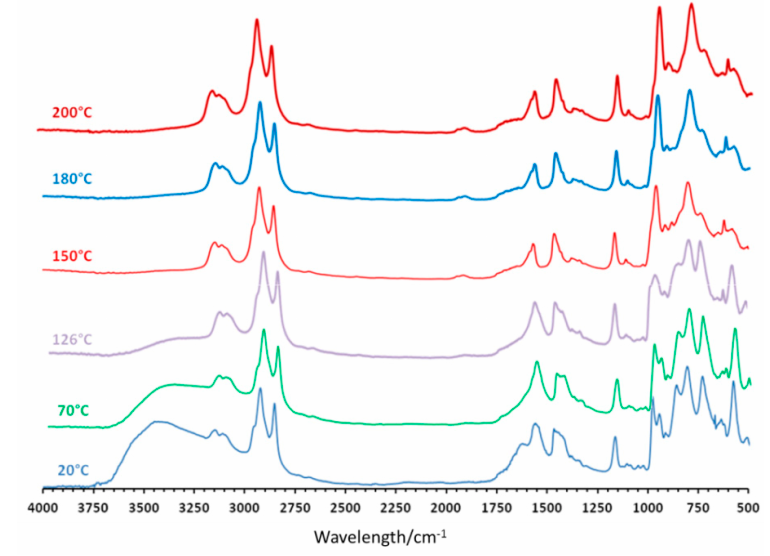
Figure 3. Selected FT-IR spectra recorded at various temperatures for compound (mimC 18 ) 37 {Mo 132 } under air.